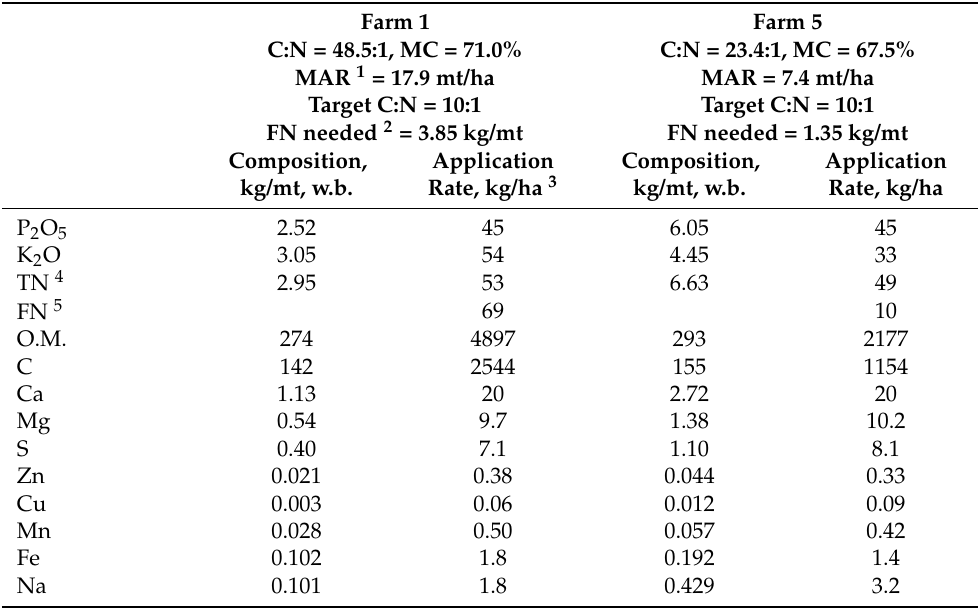
Table 7. Manure and plant nutrient application rates if horse manure is applied to provide 45 kg P 2 O 5 /ha and fertilizer N sufficient to overcome induced nitrogen